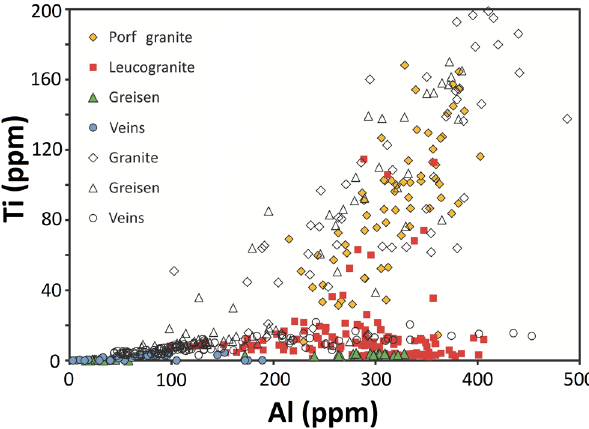
Figure 15. A comparison of our quartz data (colored symbols) with the data from borehole SCB2 and the new adit (B-W symbols) [17] in coordinates Al vs. Ti.